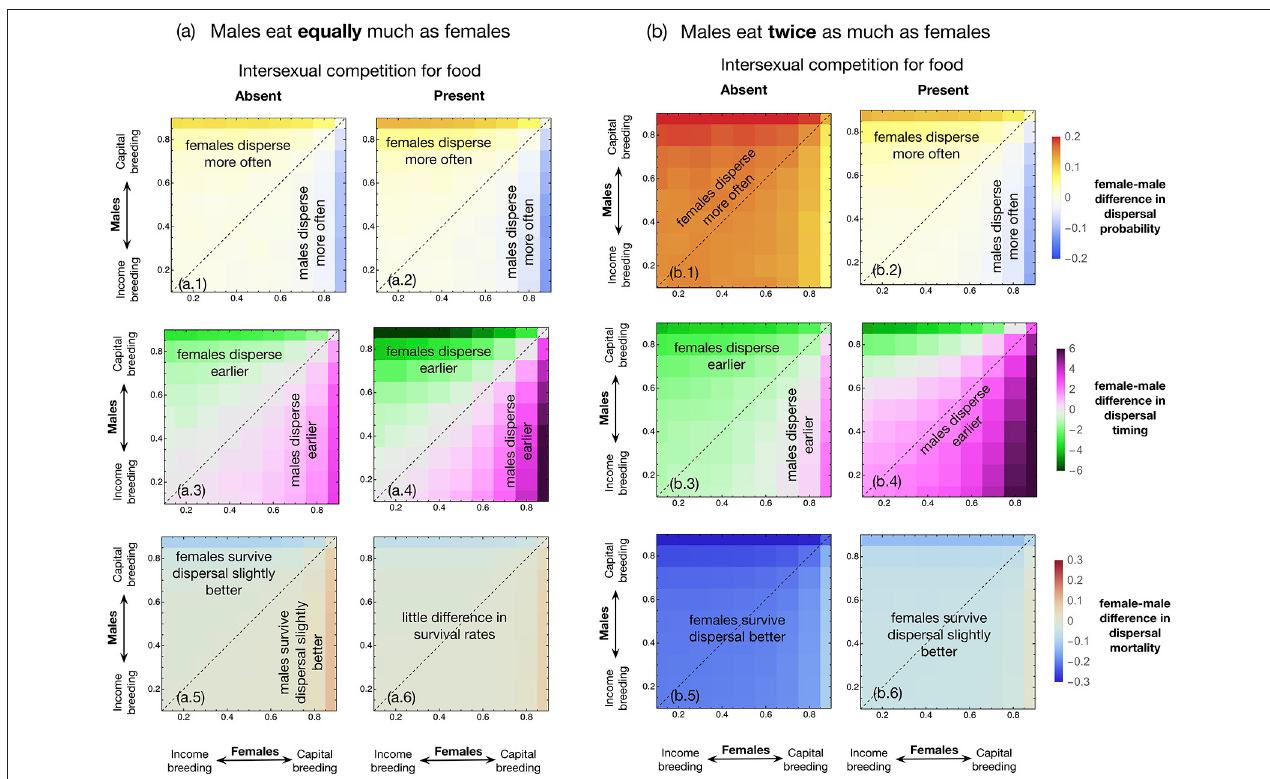
FIGURE 2 | Female-male difference in dispersal probability when (a) males and females have the same need of food consumption ( β = 1), and when (b) males need twice as much food as females ( β = 2). In each panel, the x and y axes represent the income/capital breeding parameters of females ( b f ) and males ( b m ), respectively. The parameters range from 0.1 to 0.9 with equal steps of 0.1; larger values mean more emphasis on capital (long-term resource acquisition). Panels in each row use the same color scale. The other simulation parameters and simulation conditions are the same as in Figure 1